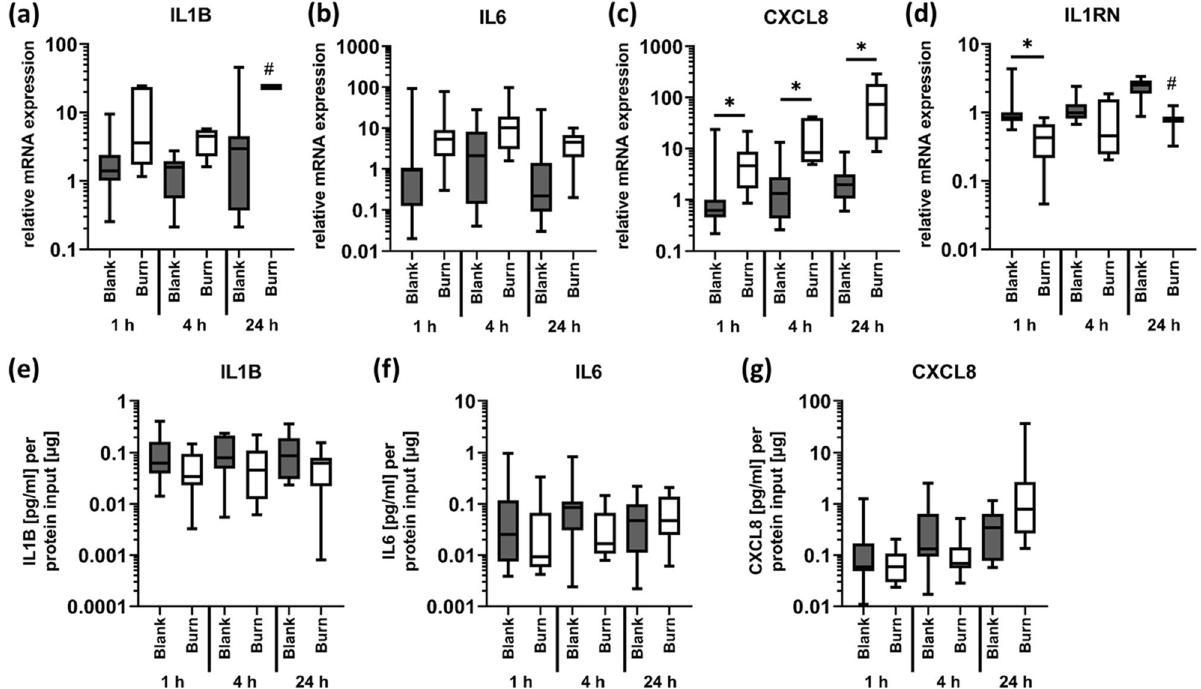
Figure 5. Local inflammatory response after burn injury. Contact burn injuries were created on fresh human skin explants by applying a heated metal block (100 °C). Biopsies were collected after 1, 4 and 24 h. Relative mRNA expression levels of ( a ) IL1B, ( b ) IL6, ( c ) CXCL8 and ( d ) IL1RN were determined by RT-qPCR, normalizing target gene expression to the averaged expression of RPLP0 and TBP. Local cytokine concentrations were measured in homogenized biopsies using the V-PLEX Proinflammatory Panel 1 Human Kit (MSD). Out of 10 candidate analytes, only ( e ) IL1B, ( f ) IL6 and ( g ) CXCL8 could be quantified. Data are presented as median (line) the interquartile range (box) and the minimum and maximum values (whiskers) from three individual skin explants. P-values < 0.05 were considered as statistically significant with *, **, *** indicating p < 0.05, p < 0.01, and p < 0.001, respectively (dependent on normal distribution ANOVA or Kruskal–Wallis test). For specific settings there were less than three values, indicated by